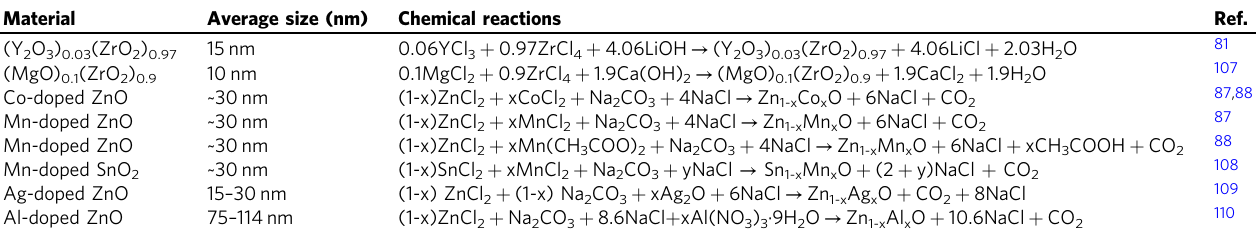
Table 2 Doped metal-oxide nanoparticles produced using the mechanochemical activation of solid-state displacement reactions. Material Average size (nm) Chemical